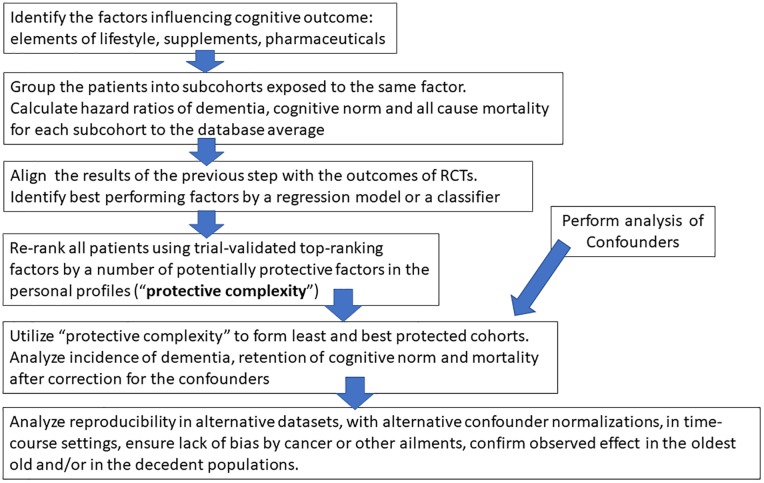
Computational screening of combined prescription drugs, supplements and lifestyle factors as potential multi-factor modifiers of dementia phenotypes.